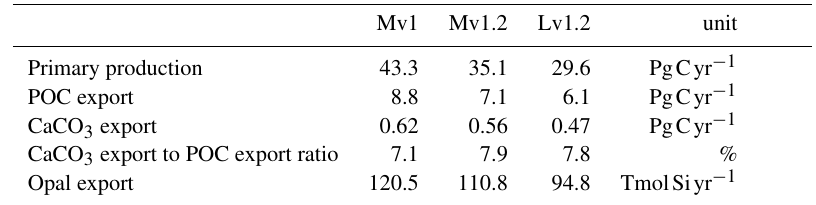
Figure 6. Vertically integrated primary production (molCm − 2 yr − 1 ) averaged over the years 2003–2012 for model configurations (a) Mv1, (b) Mv1.2, and (c) Lv1.2, and (d) the mean of three satellite-based climatologies (derived from MODIS retrievals; see text). Panel (e) displays the zonal means of each field presented in panels (a–d) . The grey shaded area represents the range of the zonal means of the three satellite-based climatologies. Table 4. Primary production and export production averaged over the years 2003 to 2012 simulated by the three model ver- sions/configurations.